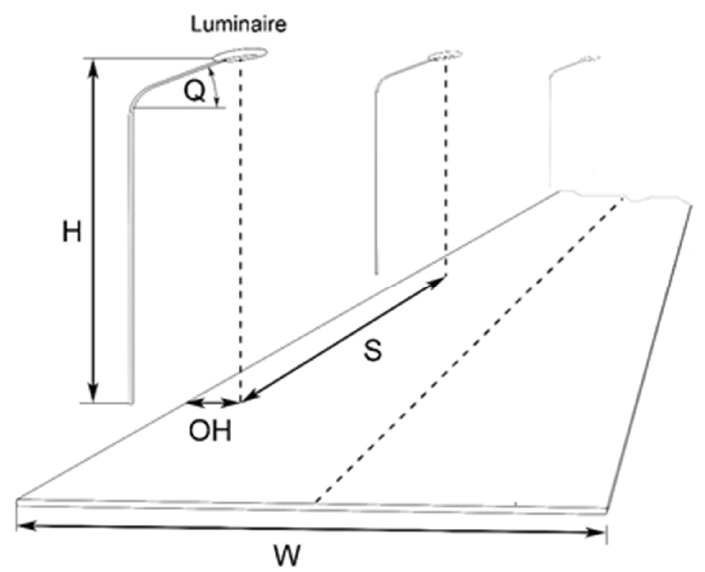
Figure 4. View of Slowackiego street where: H is the luminaire mounting height—7.0 m; W is the width of the roadway—7.0 m, S is the distance between streetlamps—25 m, OH—overhang which is 1.50 m, Q is the tilt equal to 0°.